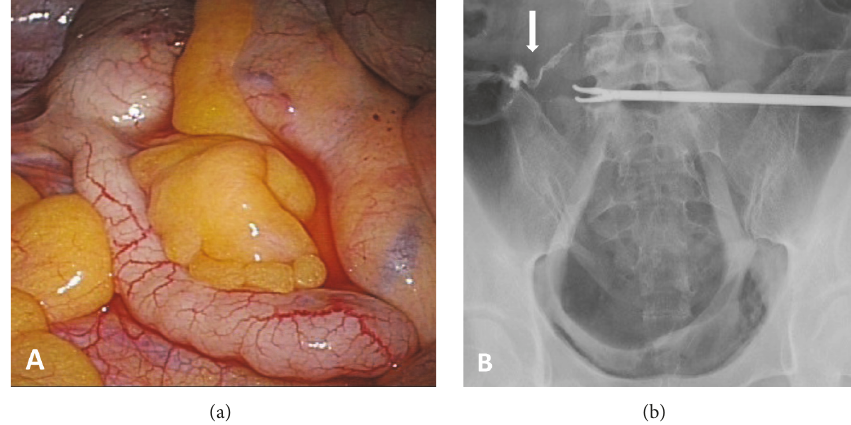
Figure 2: Examination by relaparoscopy. (a) Perioperative photo. No remnant was found where the cord-like material was assumed to exist. (b) Perioperative X-ray test. The shape and position of the material were found to be coincident with the appendix in